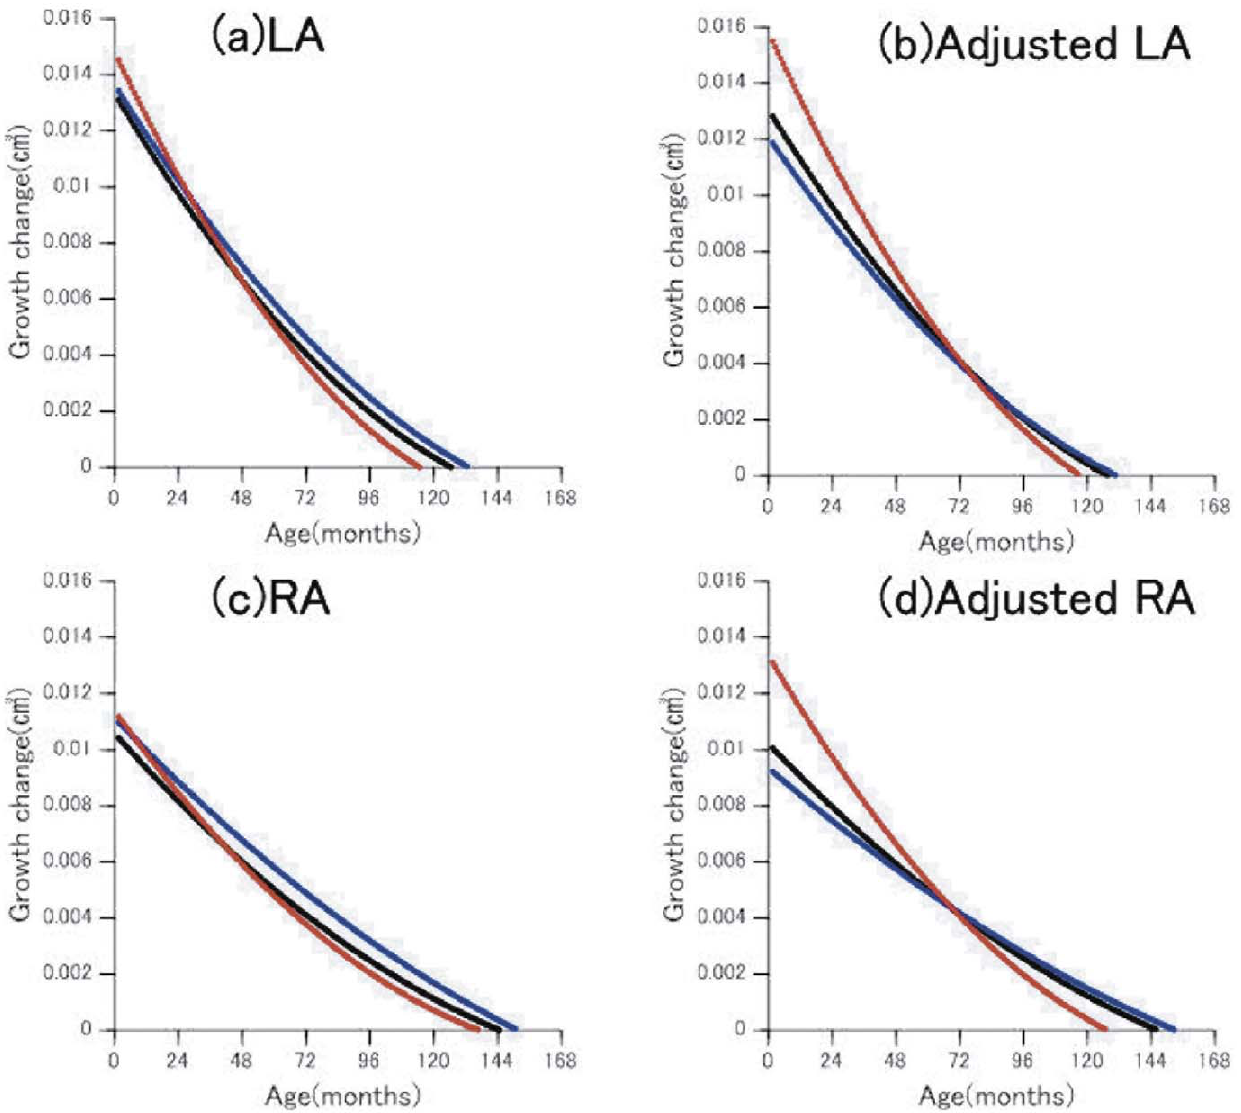
Figure 4. Rate of growth change in amygdalar volumes. (a); LA: left amygdala, (b);left amygdala adjusted by ICV, (c); RA: right amygdala, (d);right amygdala adjusted by ICV. The rates of monthly volume changes in the right and left amygdala. Positive values indicate increasing volume. The point of intersection on the x-axis represents the age of local maximal volume. Black line: whole group, blue line: males, red line: females.